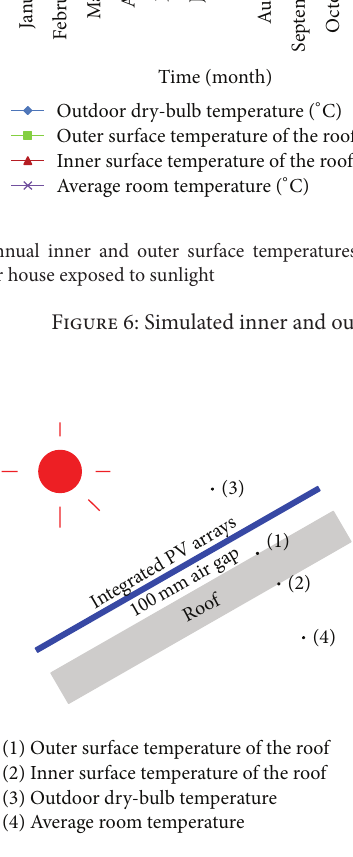
Figure 7: Temperature measurement points on the BIPV